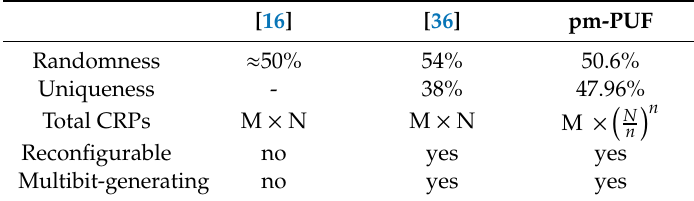
Table 2. Comparison of the pm-PUF with other memristor-based PUFs. [16] [36] pm-PUF Randomness ≈ 50% 54% 50.6%